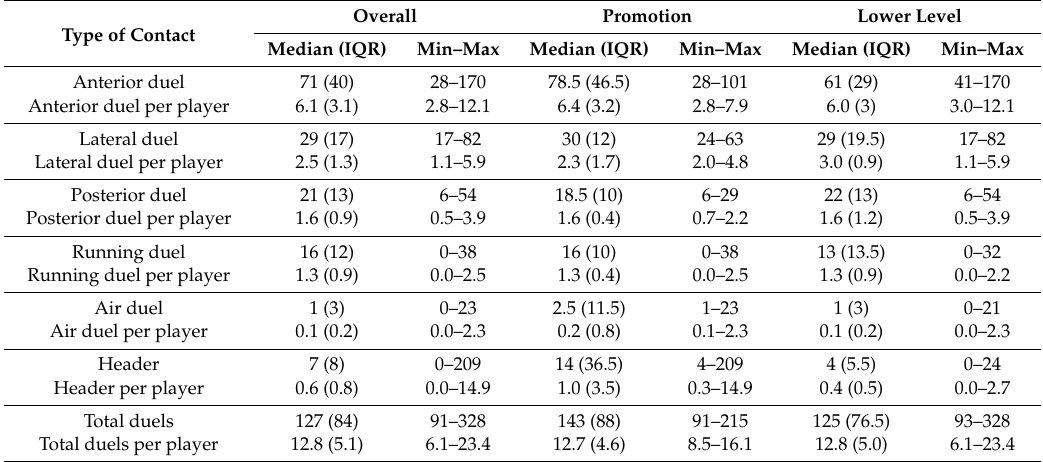
Table 5. Duels and headers during training sessions. Data presented as medians with interquartile range and minimum and maximum.